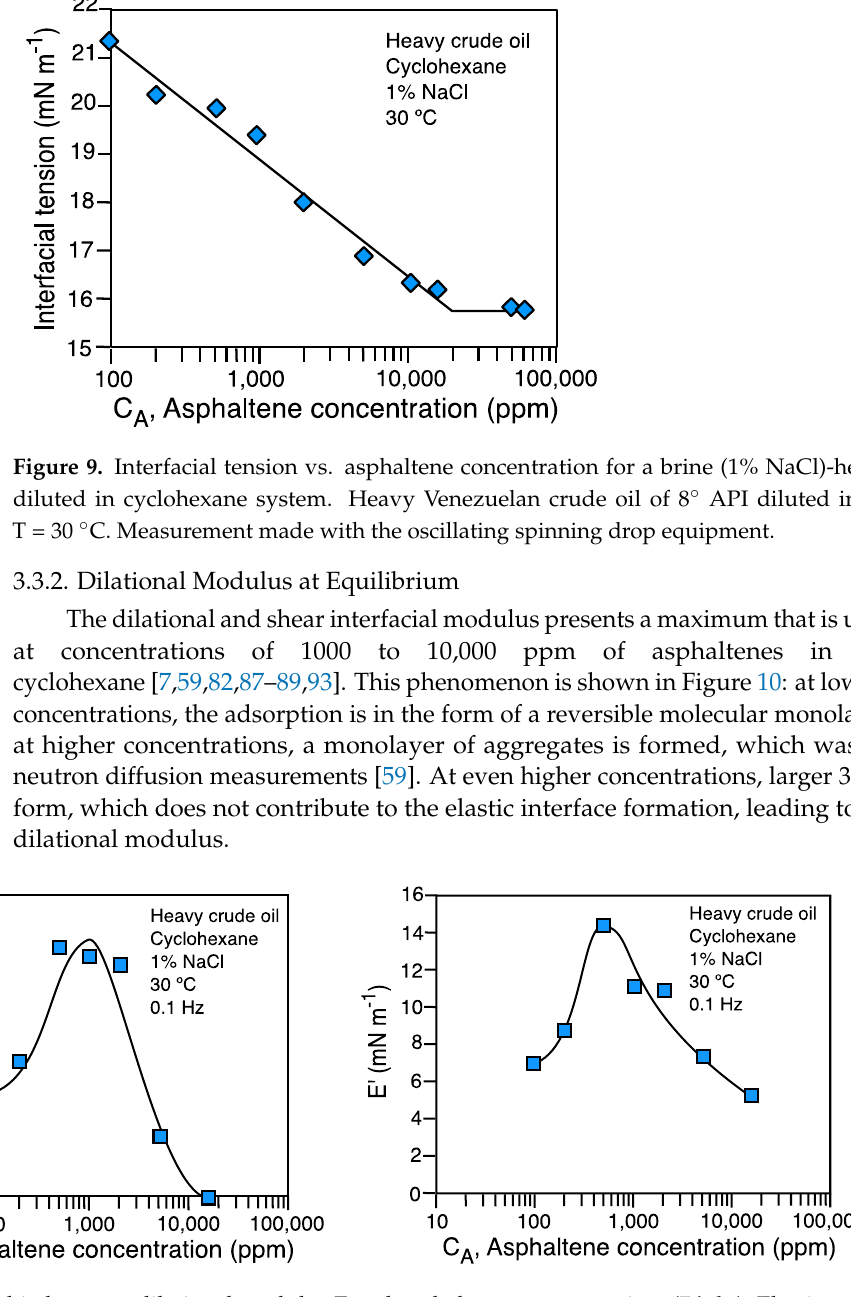
Figure 10. ( Left ): Relationship between dilational modulus E and asphaltenes concentration. ( Right ). Elastic modulus E’ vs. concentration of asphaltenes. Both systems are heavy Venezuelan crude oil diluted in cyclohexane-brine (1% NaCl). T = 30 ◦ C. Measurement made with the oscillating spinning drop equipment. Frequency = 0.1